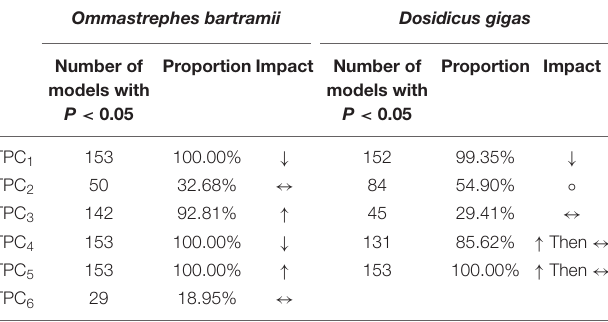
TABLE 2 | The proportion of each trend series of principal component (TPC i ) identified as significant (significant level α : 0.05) in all sub-models ( n = 153) of generalized additive models (GAM) for Ommastrephes bartramii and Dosidicus gigas , and the impact of each TPC i on the TA (smooth function) based on the generalized additive models (GAM) with all-year data (2003 ∼ 2020).